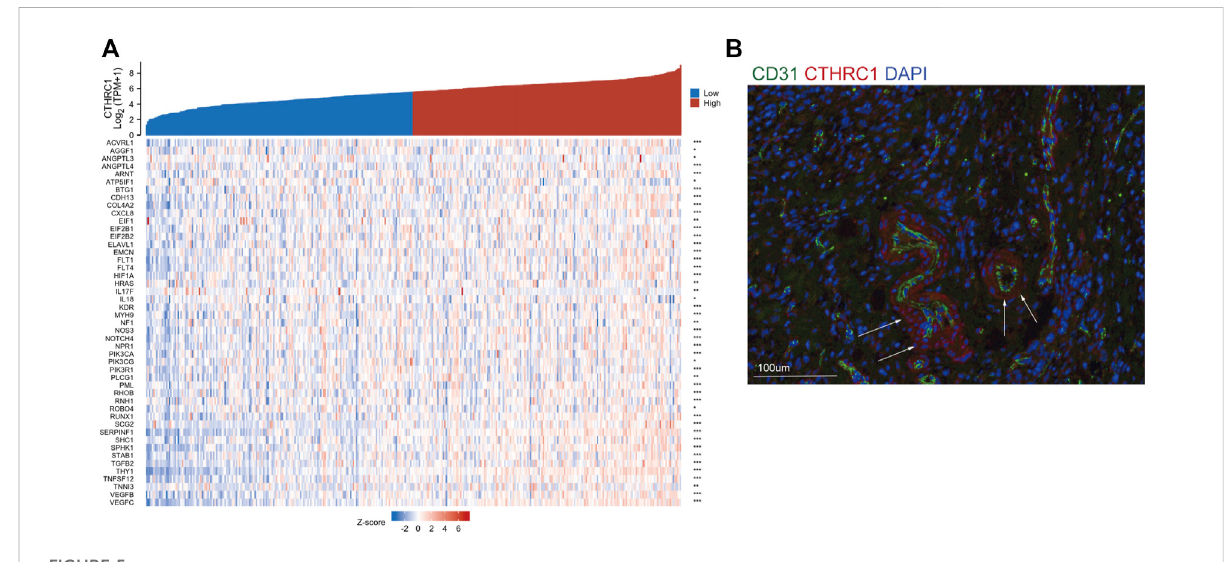
FIGURE 5 CTHRC1 expression and angiogenesis. (A) The co-expression between CTHRC1 and some angiogenesis associated genes. (B) Immuno fl uorescence staining of CTHRC1, CD31 and